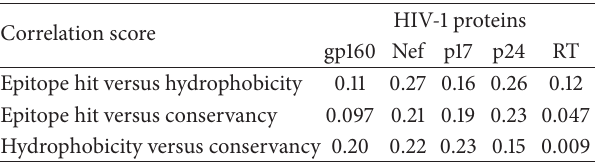
Table 4: Correlation